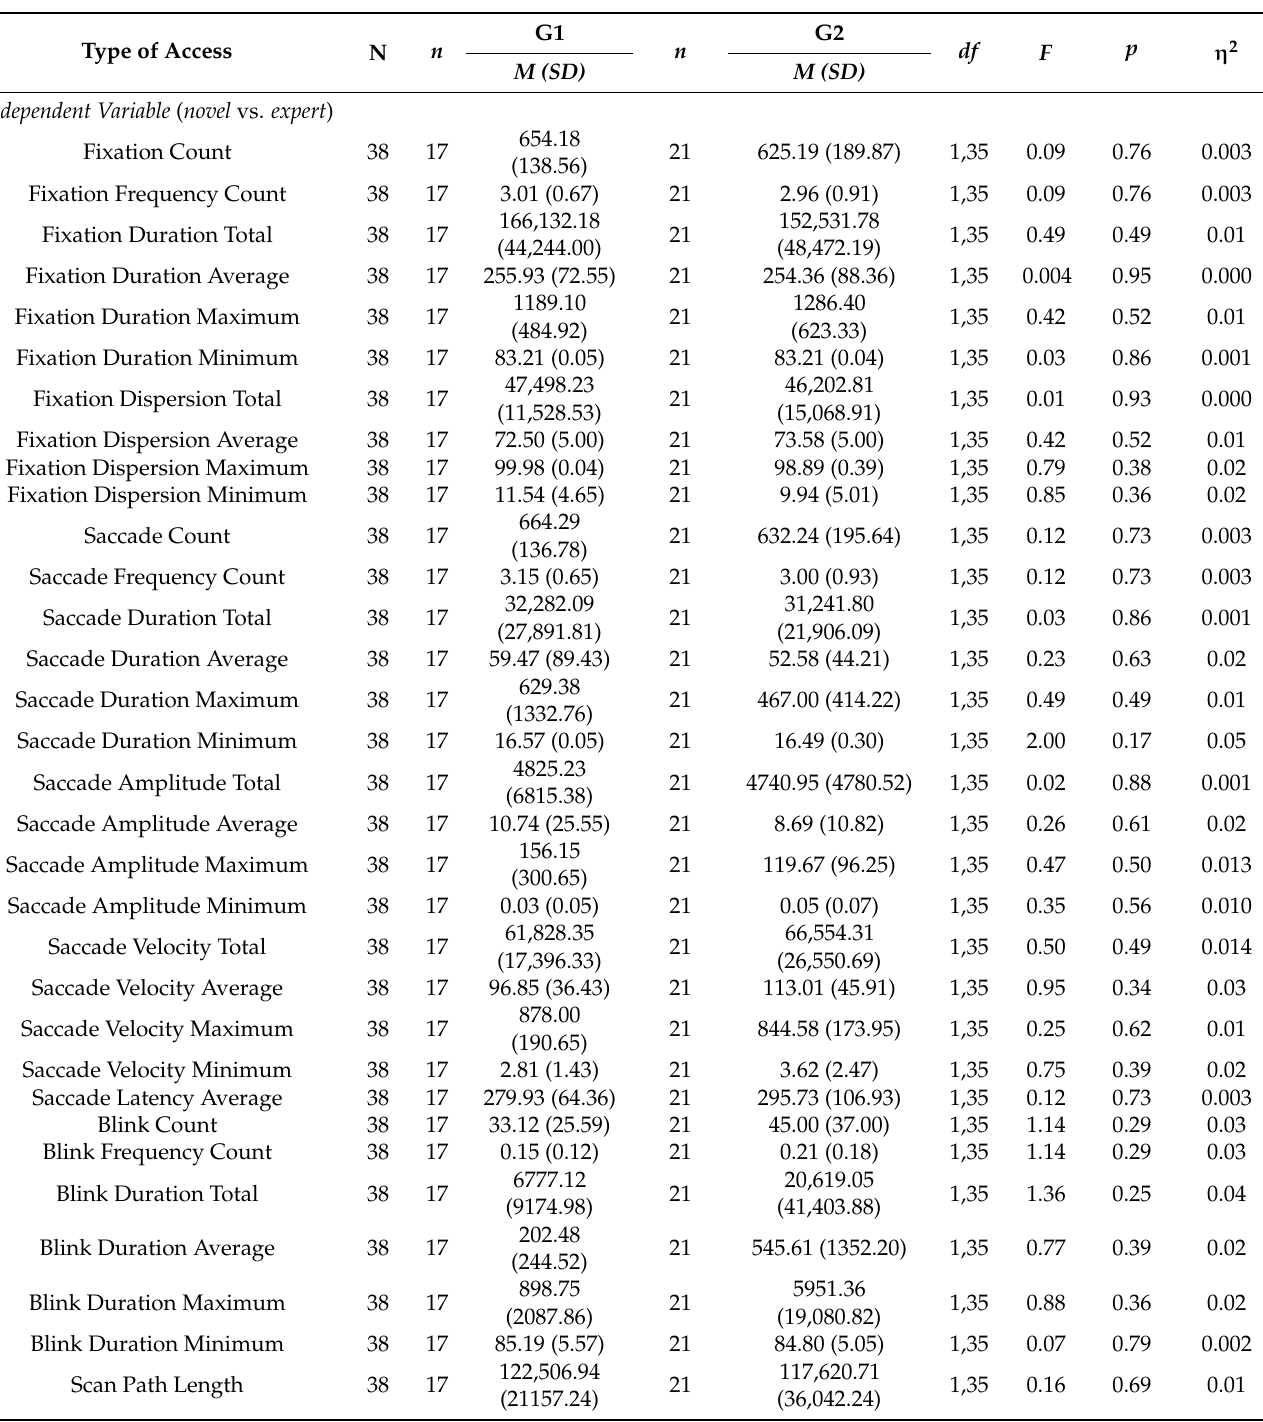
Table A1. One-factor ANCOVA with fixed effects (age over 50 vs. under 50) and covariate (student vs.